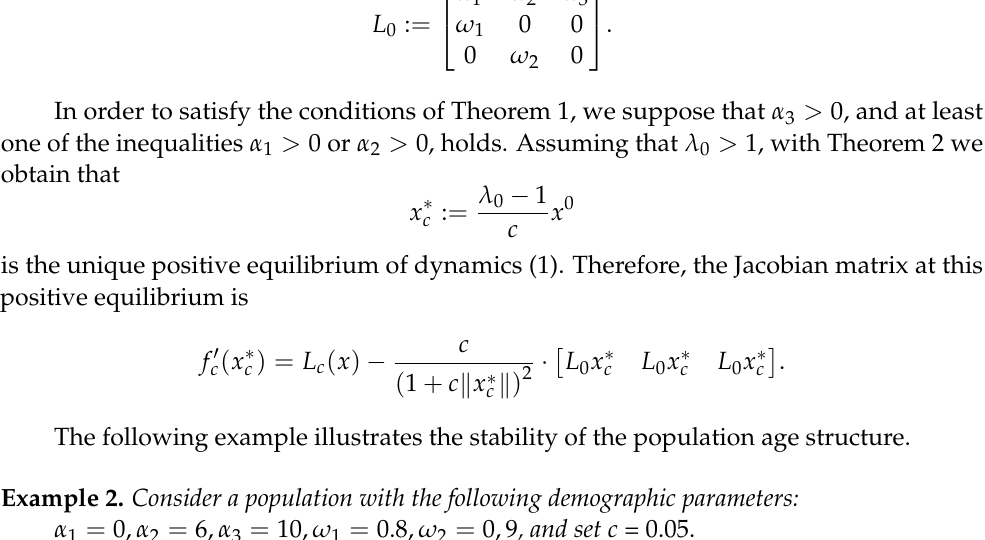
Figure 3. Trajectories running away from zero. 4. Construction of a Local Observer 4.1. Observability of the System: Observing the Second Age Class Consider the observation system consisting of dynamics (1), ),2,1,0()()1( )(